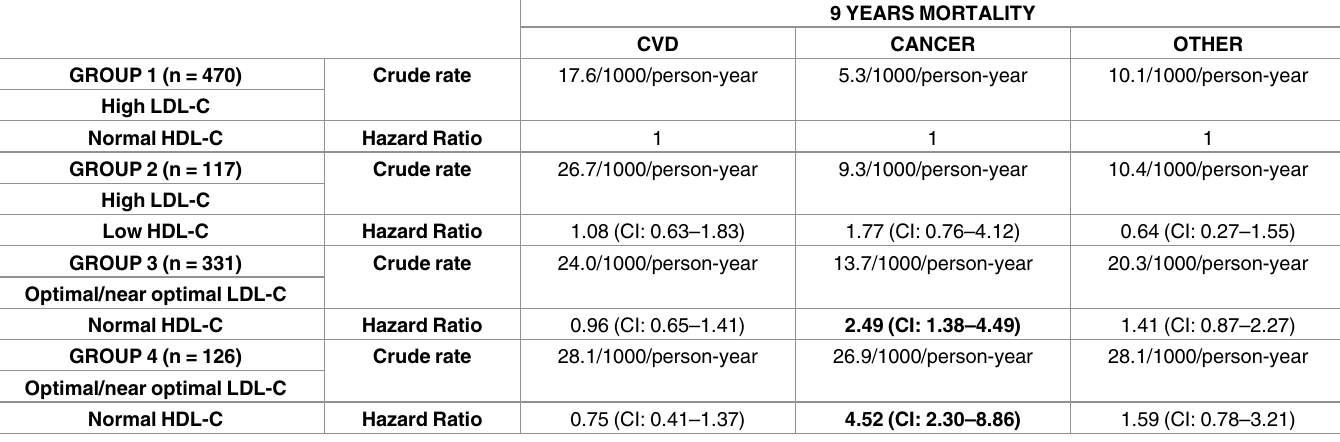
Table 3. Crude mortality rate and relative adjusted Hazard Ratio for 9 years principal causesof death (cardiovascular disease, cancer, and other causes) in 1044 community dwelling older individuals enrolled into the INCHIANTI study according to combined levels of LDL-C and